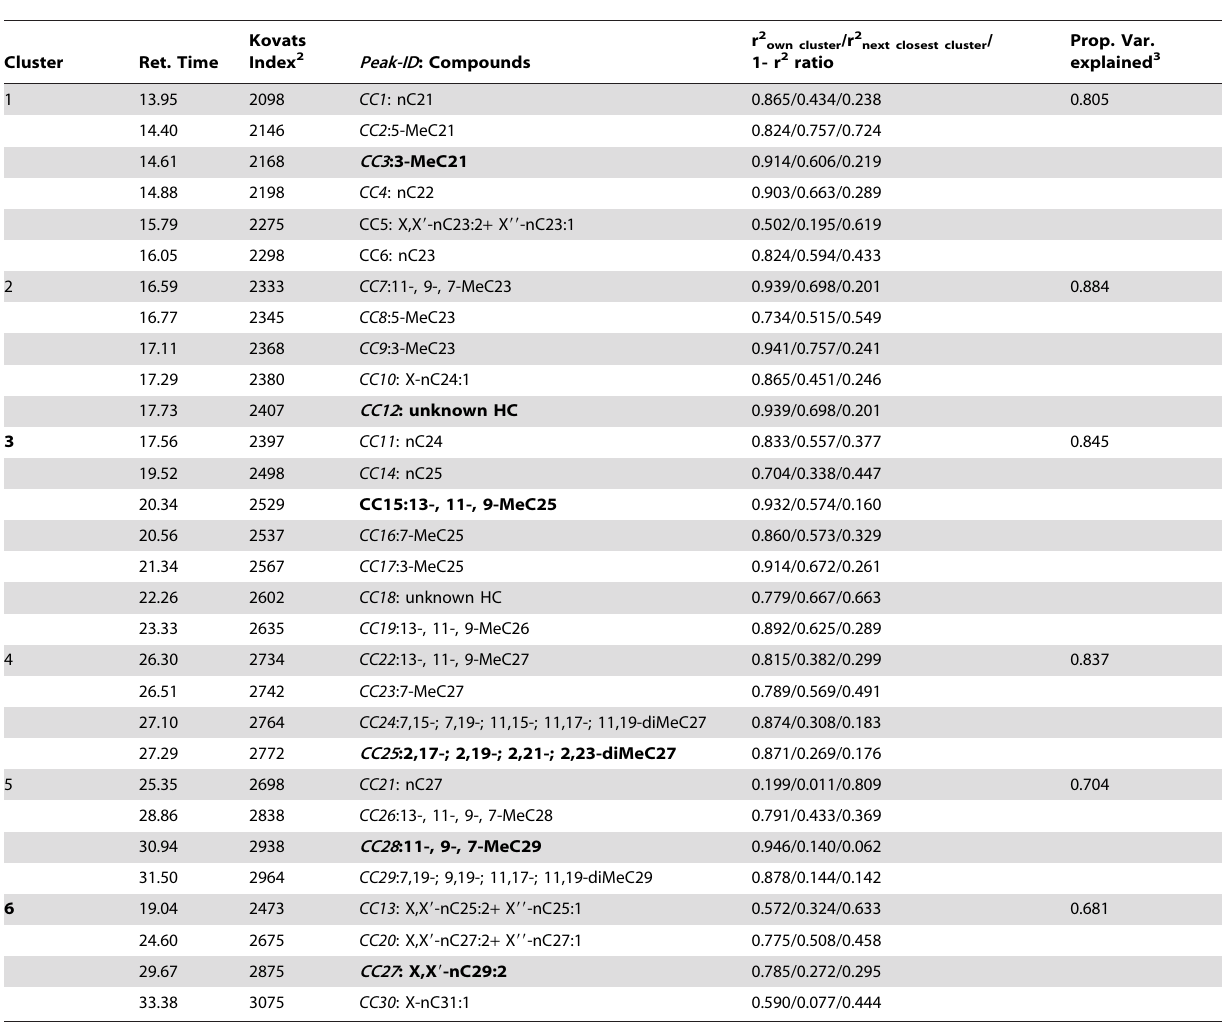
Table 1. Summary of peaks, chemical identity of maternal cuticular hydrocarbons and their statistical clustering.